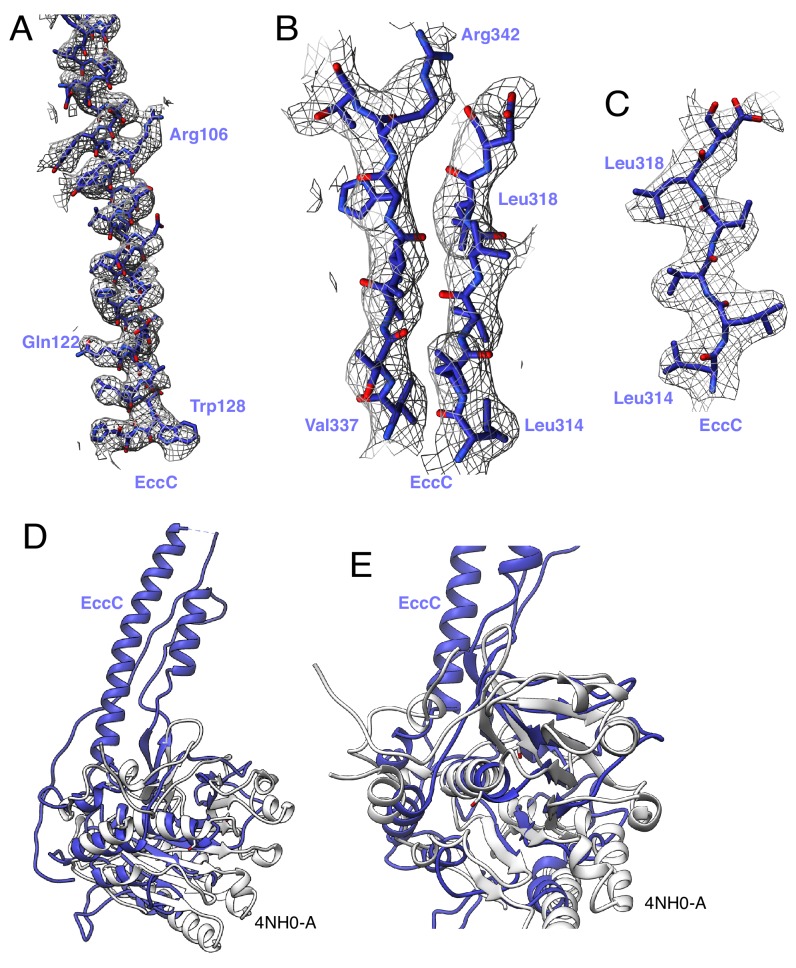
EccC3 map and model.(A) Map and model of the EccC DUF domain, amino acids amino acids 97 to 130. (B) Two beta strands in the EccC DUF domain, amino acids 314 to 319 and 337 to 343. (C) Beta strand in the EccC DUF domain, amino acids 314 to 319. (D) Overlay of the model of the EccC DUF domain with the top DALI hit, 4NH0-A (white). (E) Close up of the ATP binding pocket of 4NH0-A. The ATPase fold remains intact in the DUF domain.